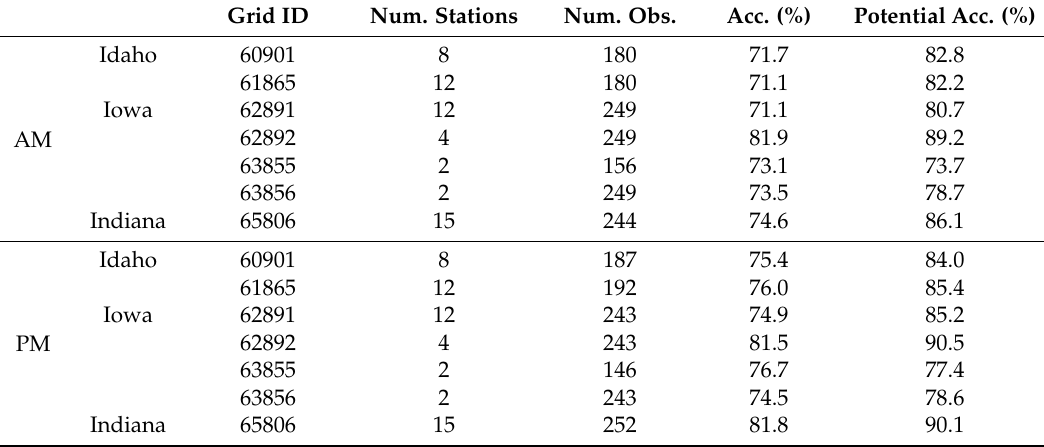
Table 6. Upper bound of SMAP retrieval accuracy for winter (October–March), by grid, for ∆ (t) thr = 0.5. Accuracy (Acc.) values are the original overall accuracy values that appear in Table 4. Potential overall accuracy was computed assuming that the SMAP FT retrieval is wrong only if more than 75% of the stations in a grid show a soil state contrary to the